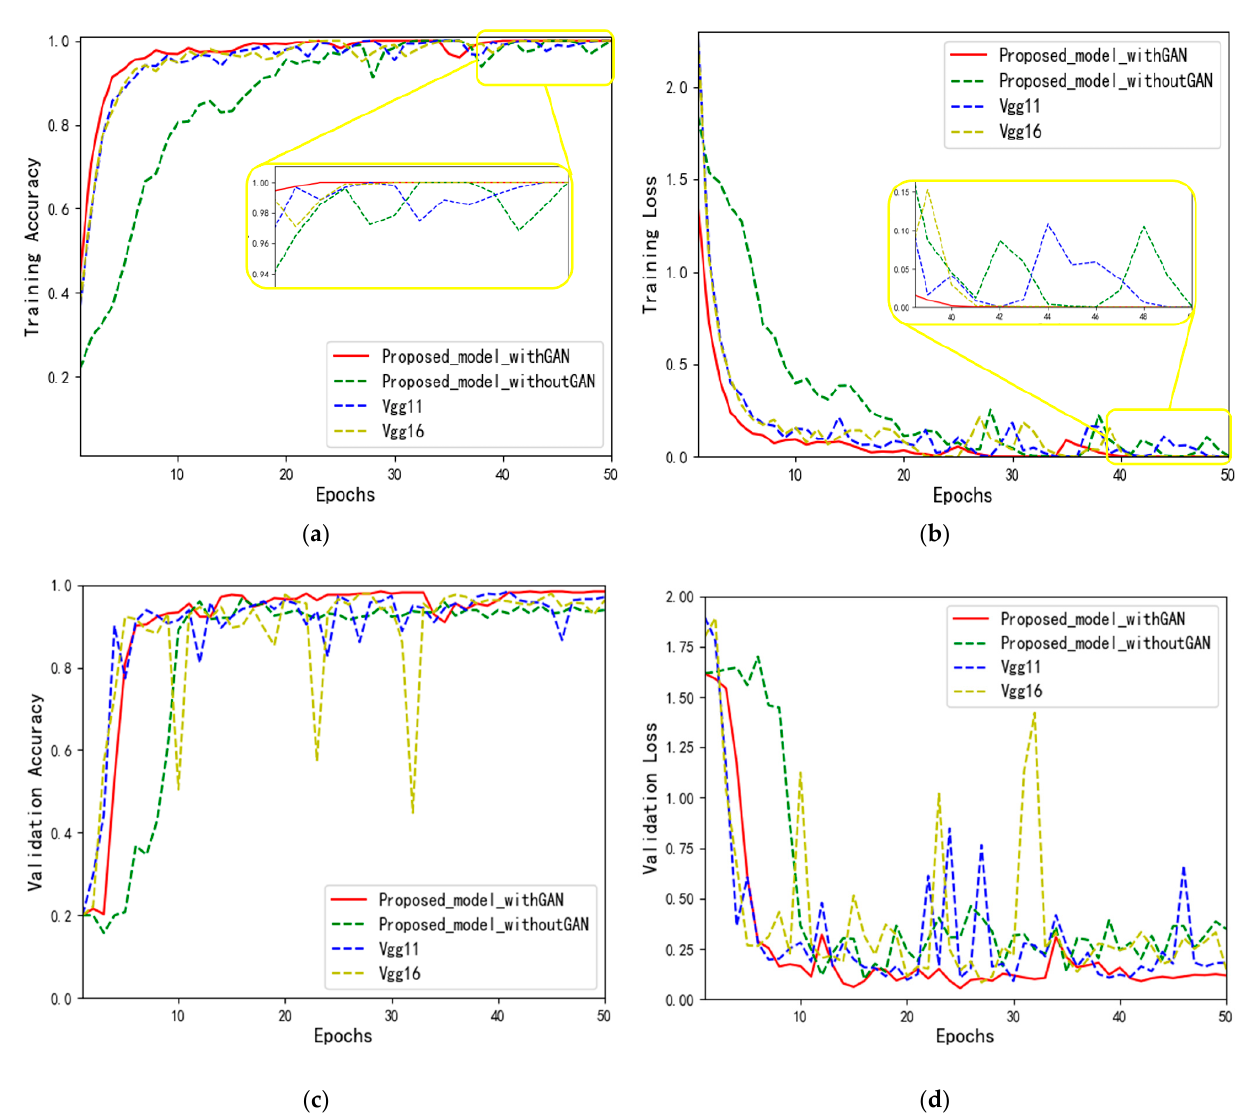
Figure 8. Comparison of results for each network model validation sets: ( a ) Course of training accuracy; ( b ) course of training loss; ( c ) course of validation accuracy; ( d ) course of validation loss.